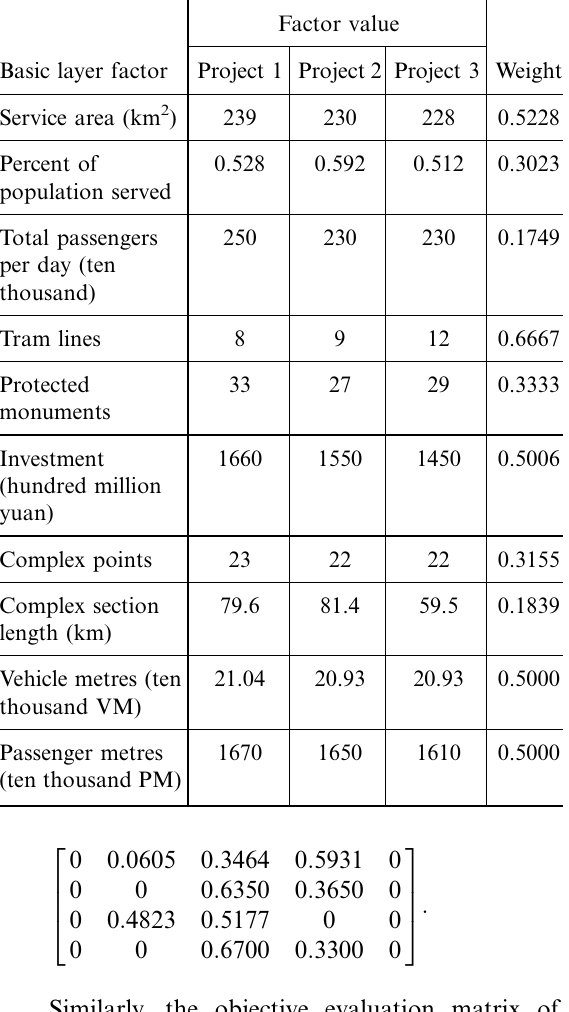
Table 3. Values and weights of the basic layer factors Factor value Basic layer